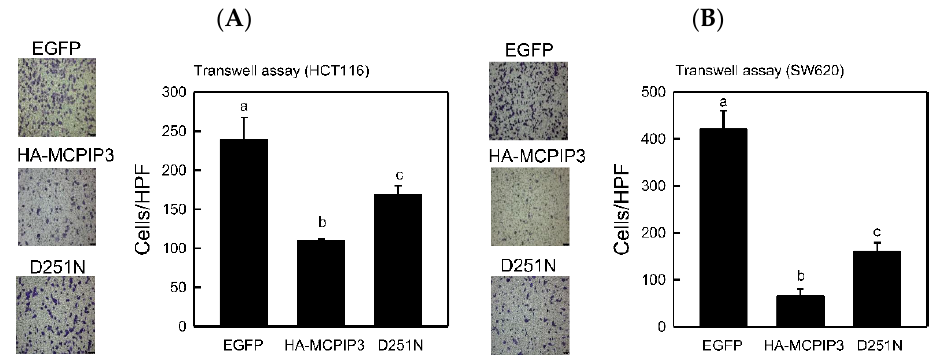
Figure 6. Effects of MCPIP3 and MCPIP3-D251N mutant overexpression on the cell invasiveness of human HCT116 and SW620 colorectal cancer cells. ( A ) HCT116 and ( B ) SW620 cells were transduced with a lentiviral vector (at an MOI of 3) expressing the indicated enhanced green fluorescent protein (EGFP), HA-MCPIP3, and HA-MCPIP3-D251N mutant for 48 h, and cell invasion by equal amounts of transduced cells was examined with a Transwell invasion assay for 24 h. Migrated cells were stained with crystal violet and cell numbers were counted in a high-power field (HPF) (magnification ×200). Each value represents the mean ± SE from three independent experiments. Values not sharing a same superscript letter are significantly different ( p < 0.05).